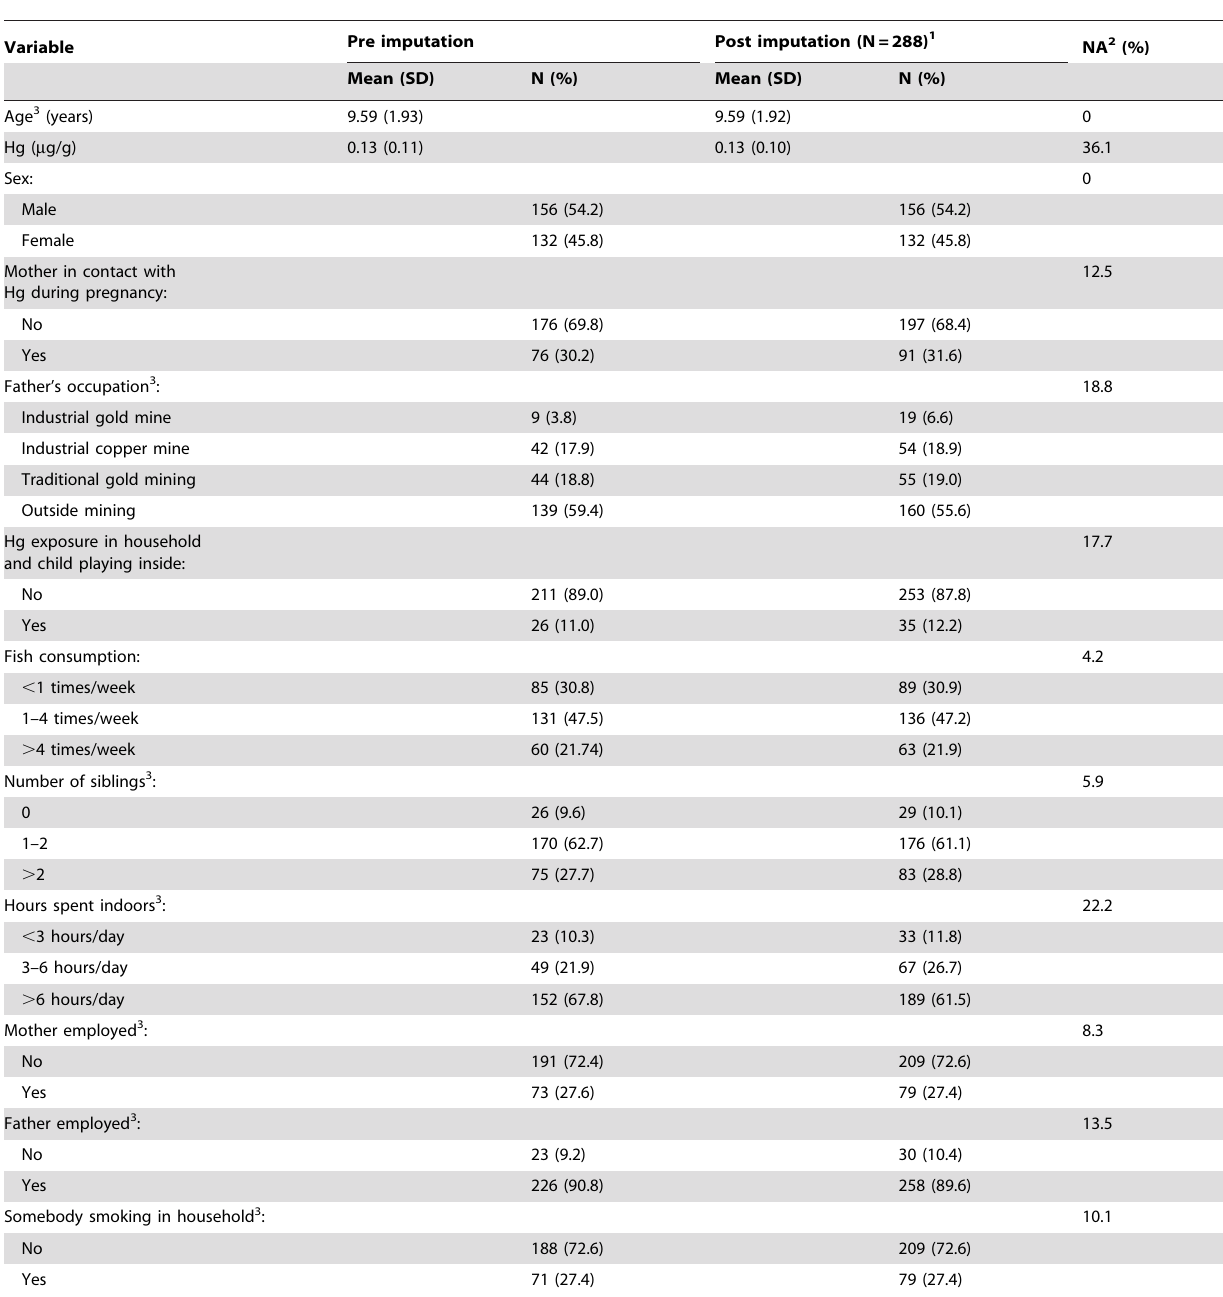
Table 3. Pre and post imputation descriptives of all study